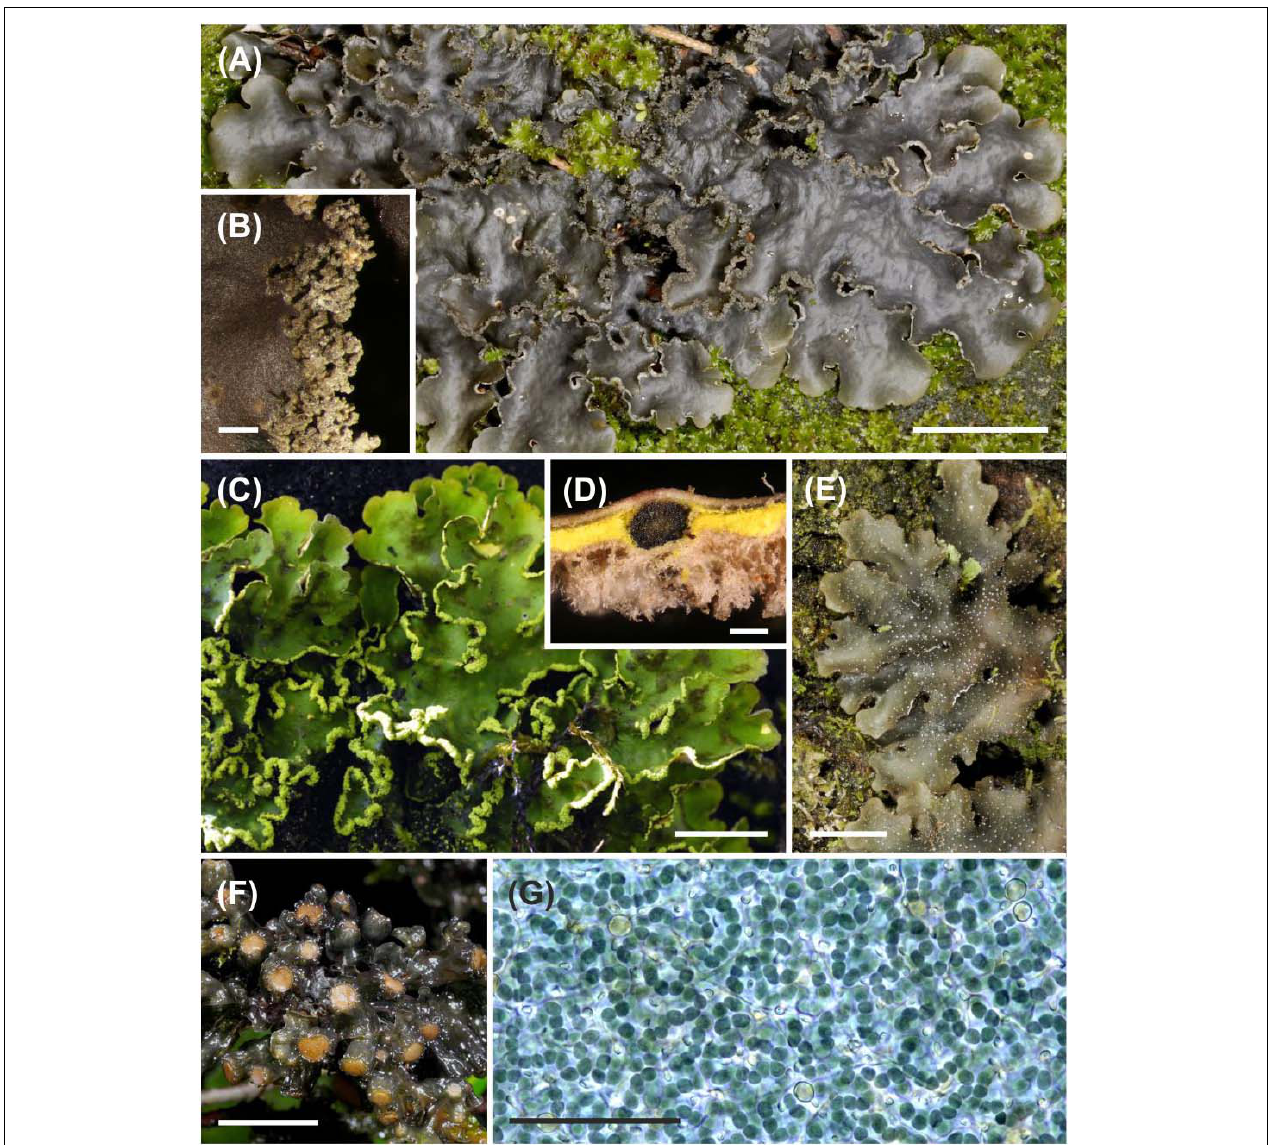
FIGURE 1 | Structural diversity of cyanolichens in the Taita Hills, Kenya. (A) Common bipartite cyanolichen Sticta sublimbata . (B) Sticta sublimbata produces coralloid aggregates of soredia (symbiotic propagules containing Nostoc cyanobionts) on thallus margins. (C) Cephalodiate lichen Crocodia aurata with green algal photobiont layer and powdery soredia (symbiotic propagules containing also green algal Dictyochloropsis photobionts) on thallus margins. (D) Nostoc cyanobionts of Crocodia aurata are housed in cephalodia within the yellow medulla of the thallus. (E) Pseudocyphellaria argyracea , another relatively common bipartite cyanolichen species. (F) The mycobiont of the bipartite cyanolichen Leptogium javanicum produces sexual ascospores in abundant apothecia. (G) Nostoc cyanobiont of Leptogium OTU K14, the large hyaline cells are nitrogen-fixing heterocysts. Scale bars, 1 cm in (A) ; 0.5 mm in (B) ; 5 mm in (C,E,F) ; 0.1 mm in (D) ; and 50 µ m in (G) .